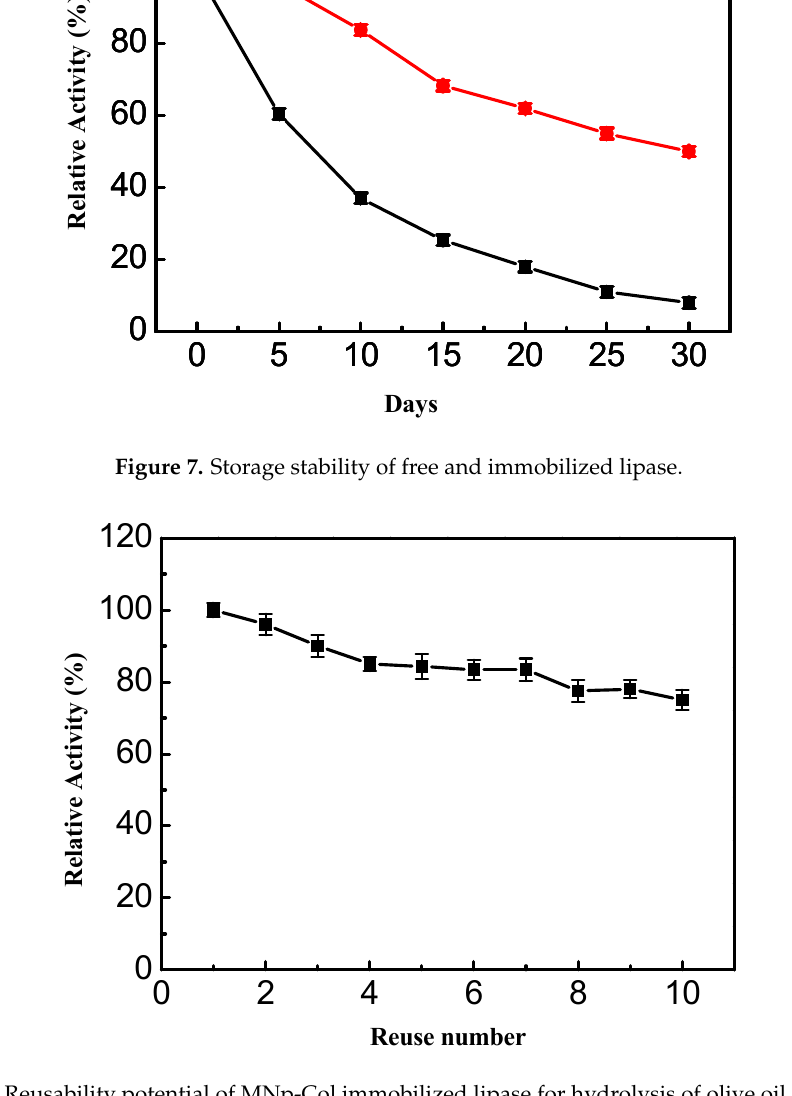
Figure 8. Reusability potential of MNp-Col immobilized lipase for hydrolysis of olive oil emulsion.